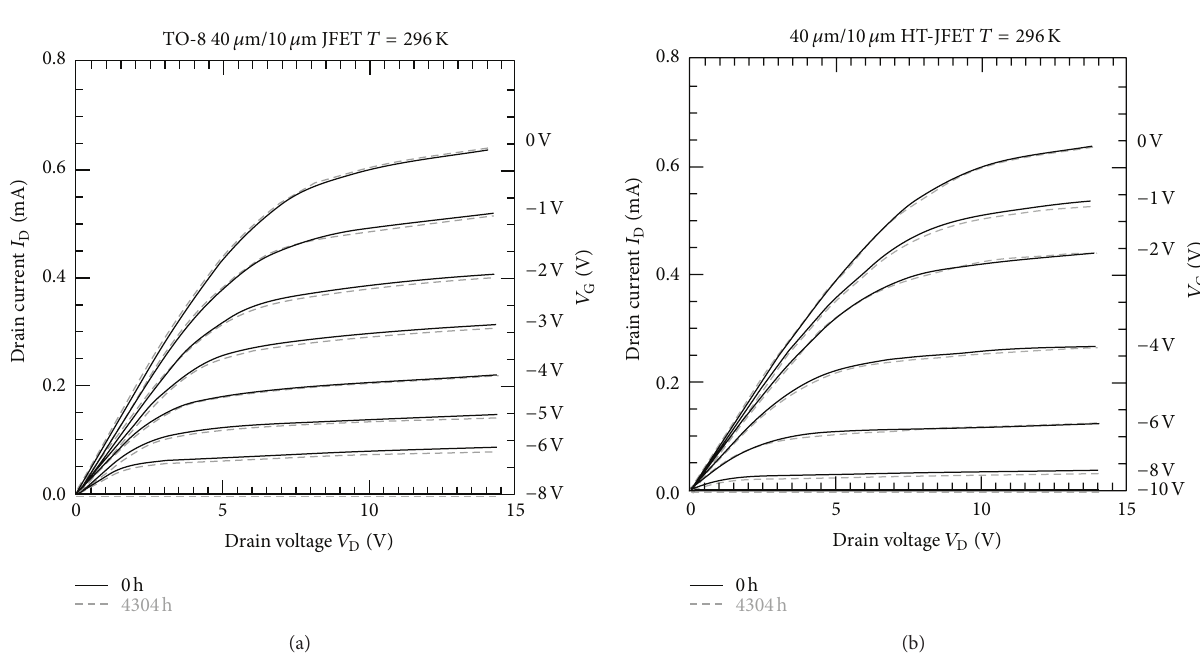
Figure 6: Current versus voltage transfer curves for given gate voltages of the two flight silicon carbide (SiC) Junction Field Effect Transistors (JFETs). (a) shows characteristics for room temperature packaged JFETs, for preflight, and after over six months of flight. (b) shows the characteristics for the high temperature packaged SiC JFET (image courtesy of